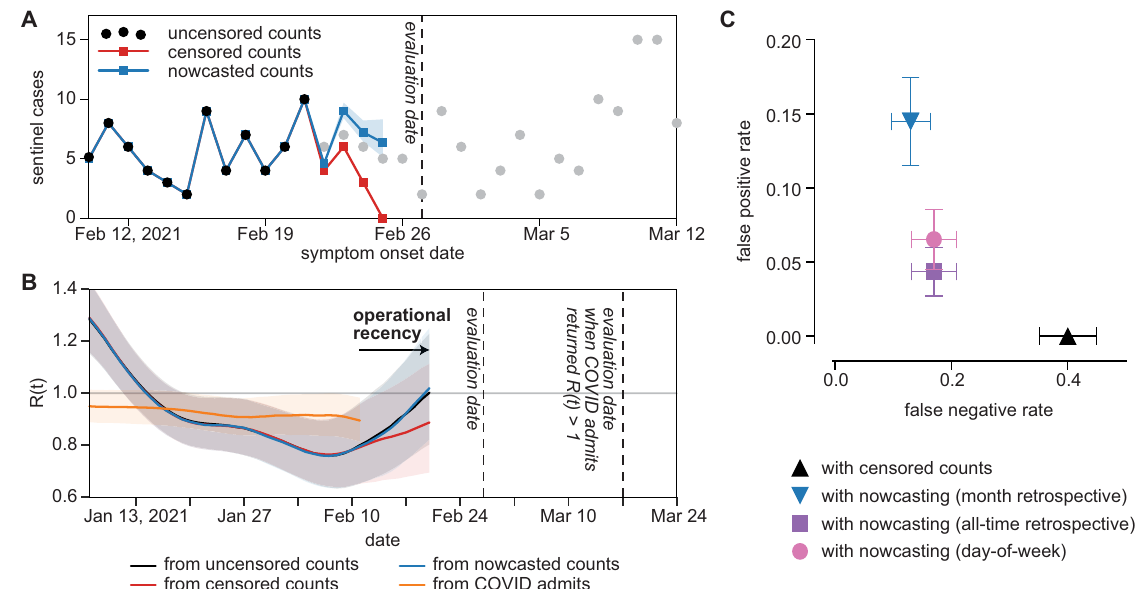
Fig.5|Operationalperformanceofsentinelsurveillance.A Sentinelcasecounts for a representative evaluation date of February 27, 2021. Black dots: sentinel case counts fully accessible on the evaluation date. Gray dots: sentinel case counts partially accessible or not yet accessible on the evaluation date. Red dots: right- censored sentinel case counts available on the evaluation date. Blue dots: median nowcasted sentinel case counts with a past-month retrospective model. Blue sha- ded region: 95% con fi dence interval for nowcasted counts. B R ( t ) derived from